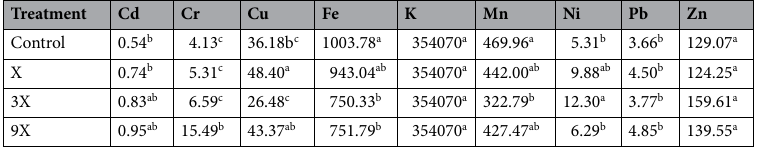
Table 3. Average heavy metals concentrations in plant (vegetative part) [ppm]. Means in the same column with similar superscripts are not statistically different (Duncan test, P ≤ 0.05).